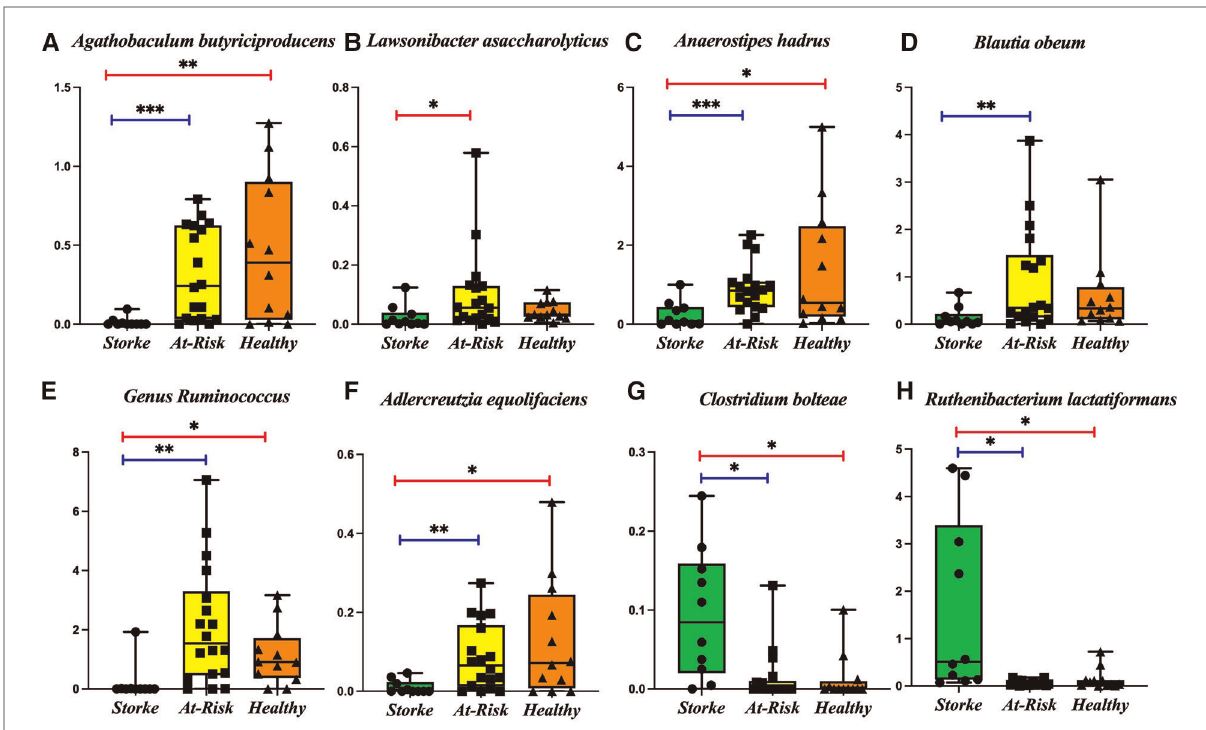
FIGURE 1 Bacterial taxa signi fi cantly changed in the stroke as compared to At-risk and healthy groups. The following taxa are lower in the stroke group: ( A ) Agathobaculum butyriciproducens , ( B ) Lawsonibacter asaccharolyticus , ( C ) Anaerostipes hadrus , ( D ) Blautia obeum , ( E ) Genus Ruminococcus , ( F ) Adlercreutzia equolifaciens , The following taxa are higher in the stroke group: ( G ) Clostridium bolteae , ( H ) Ruthenibacterium lactatiformans . * p -value<0.05; ** p -value<0.01; *** p -value<0.001.